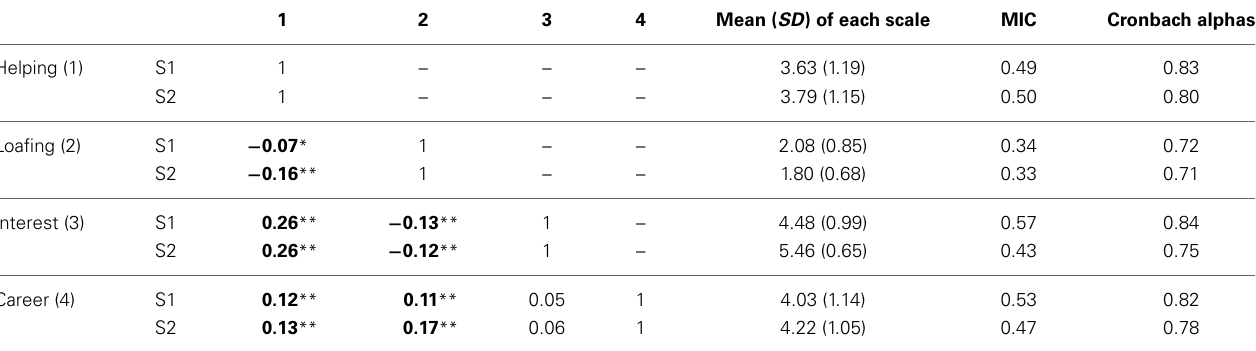
Table 2 | Correlations, descriptives (mean and SD ), Cronbach alphas and mean inter-item correlations (MICs) for Sample 1 (S1, N = 989) and Sample 2 (S2, N =